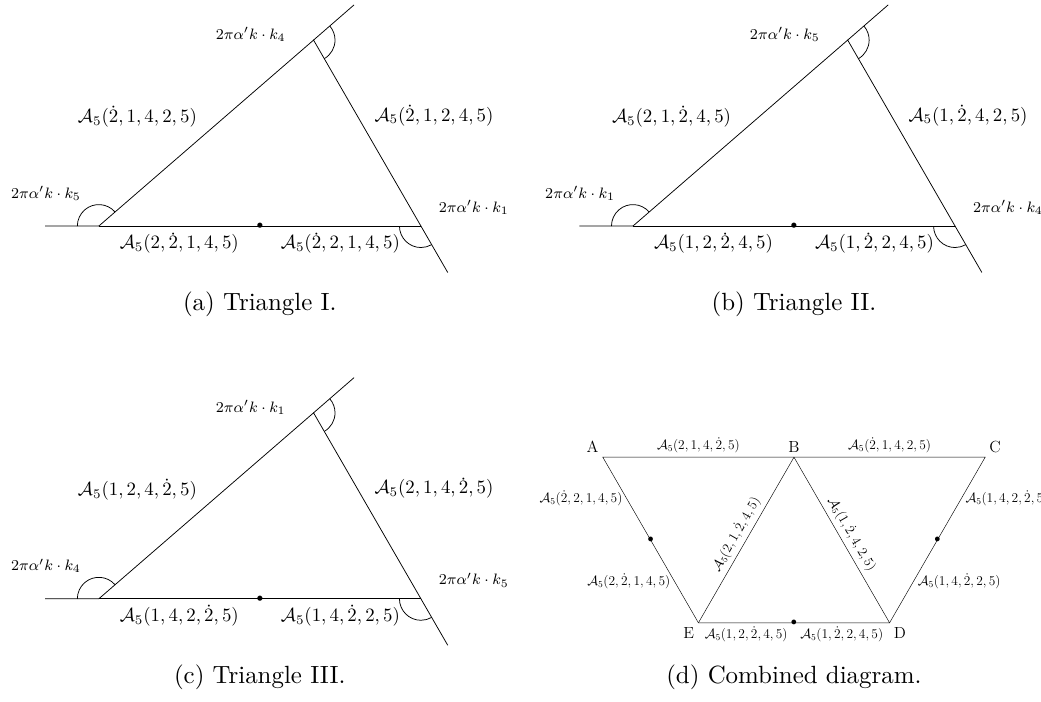
Figure 11. Plahte diagrams for 5-point tachyonic scattering with k 2 = k 3 = k